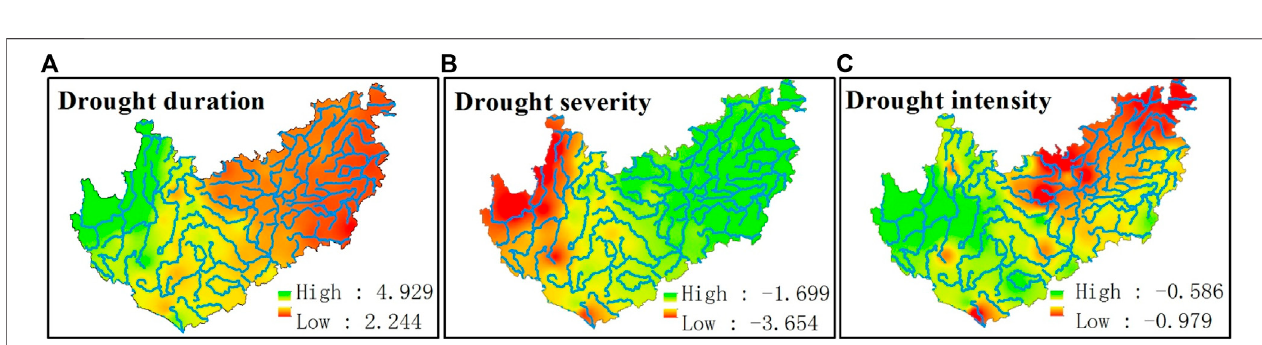
FIGURE 9 | Distribution of duration (A) , severity (B) , and intensity (C) of